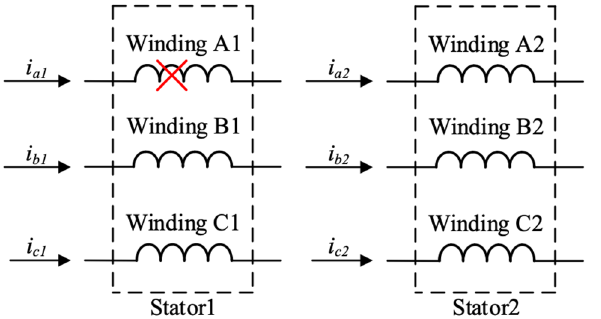
Figure 9. Schematic diagram of one-phase open-circuit (phase A1 open-circuit) fault condition. Suppose that the regulated phase angle of phase B1 and C1 are α 1 and α 2 ,